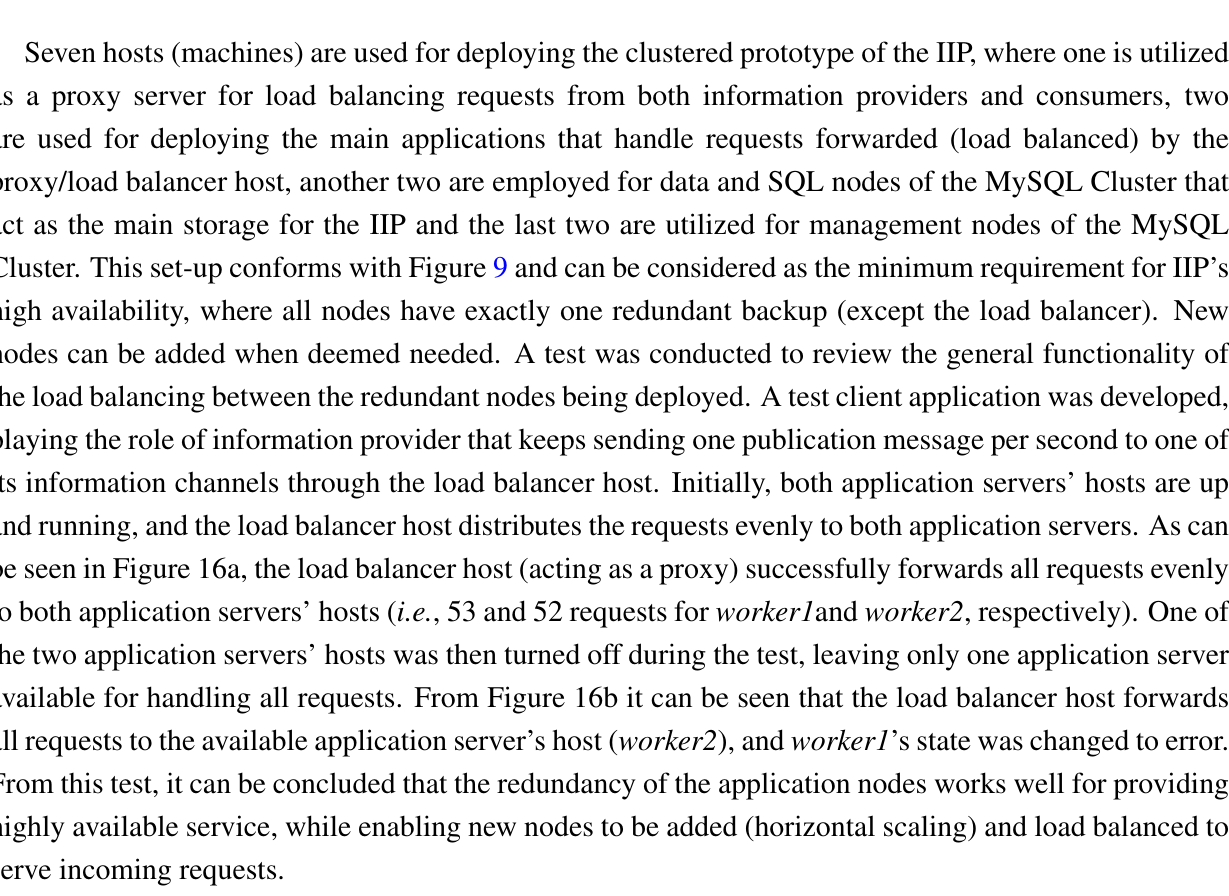
Figure 16. Snapshot of mod jk status worker: ( a ) Both application nodes are up and running; ( b ) One application node ( worker1 ) is